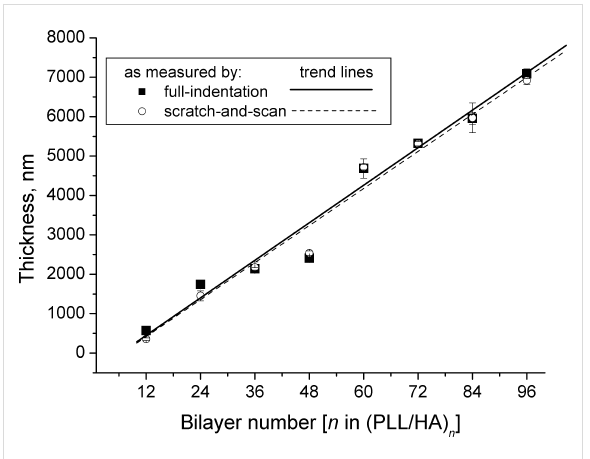
Figure 3: Thickness of (PLL/HA) n as a function of n as measured by scratch-and-scan and full-indentation methods. There is a good agree- ment between the two methods, and the thickness grows linearly with n . Error bars indicate the standard